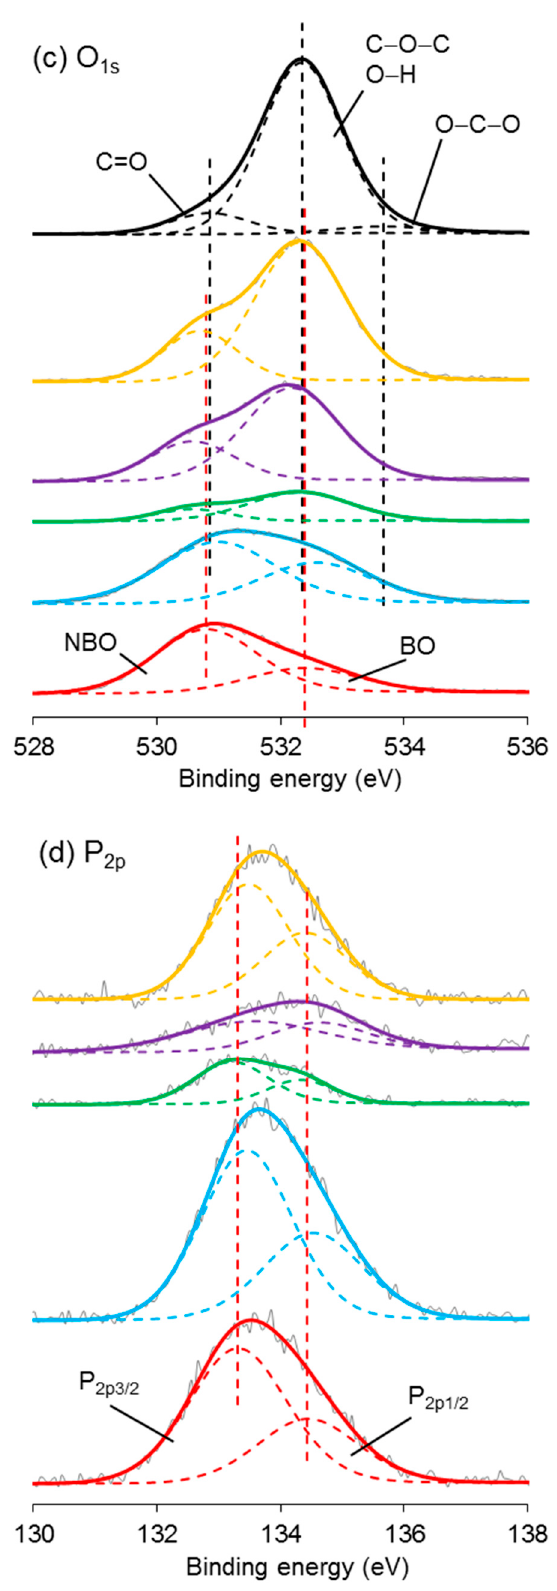
Figure 8. X-ray photoelectron spectroscopy (XPS) spectra of ( a ) C 1s , ( b ) N 1s , ( c ) O 1s , and ( d ) P 2p narrow scans of coated/uncoated fibres and pure CS powders. Table 5. Binding energy and atomic ratio of N 1s peaks in XPS spectra.